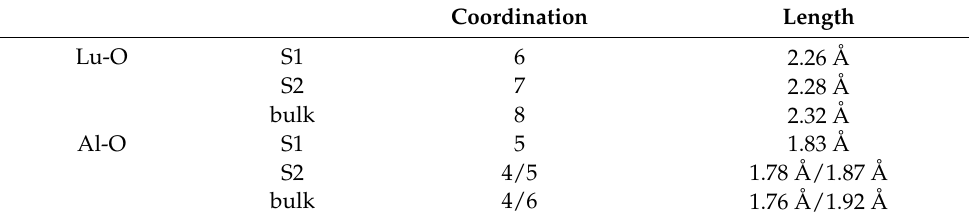
Figure 1. Structure of ( a ) optimized bulk Lu 3 Al 5 O 12 and unoptimized and optimized Lu 3 Al 5 O 12 (001) terminated with layer ( b , d ) S1 and ( c , e ) S2. The Lu, Al, and O atoms are shown in blue, green, and red. Table 1. Calculated structural data of the Lu-O and Al-O bonding in the surface and bulk.